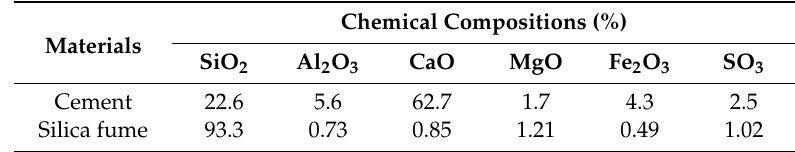
Table 1. Chemical compositions of Portland cement and silica fume.